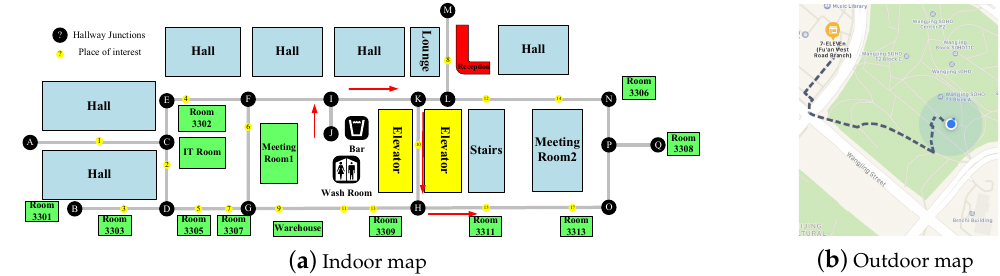
Figure 3. Examples of planned path: ( a ) A global path from bar to room3311 is represented by the red arrow. ( b ) A global path from an office building to a 7-eleven is depicted by the dashed